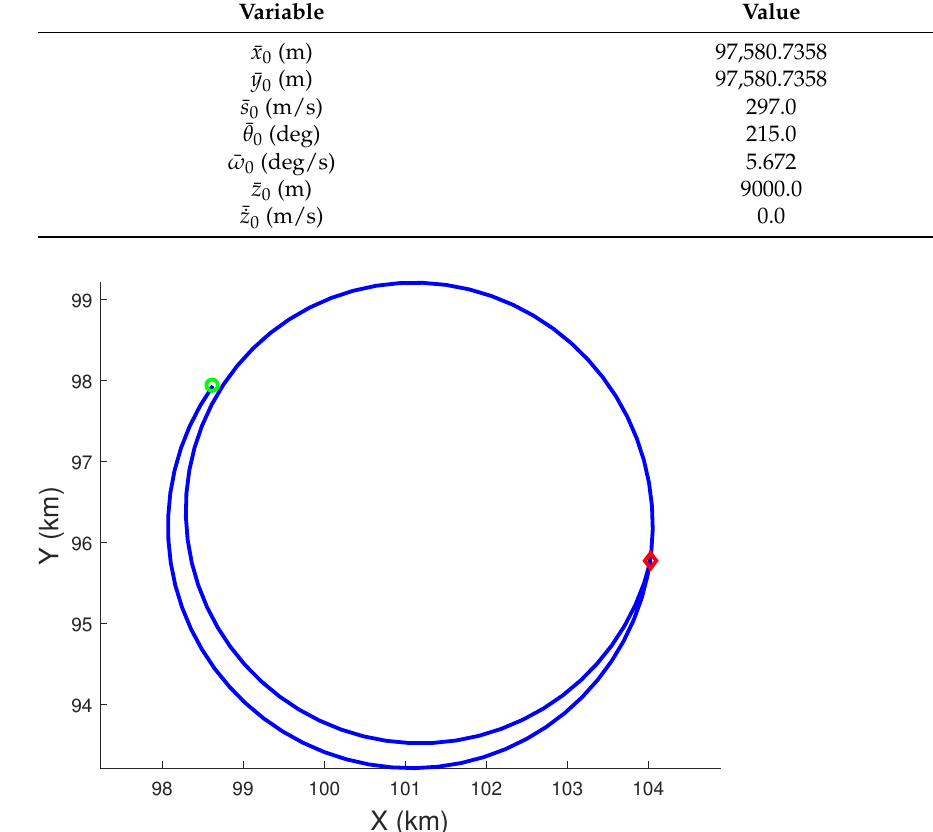
Figure 3. Target true trajectory in the XY -plane from the first Monte Carlo run. The green circle and the red diamond represent the start point and end point,